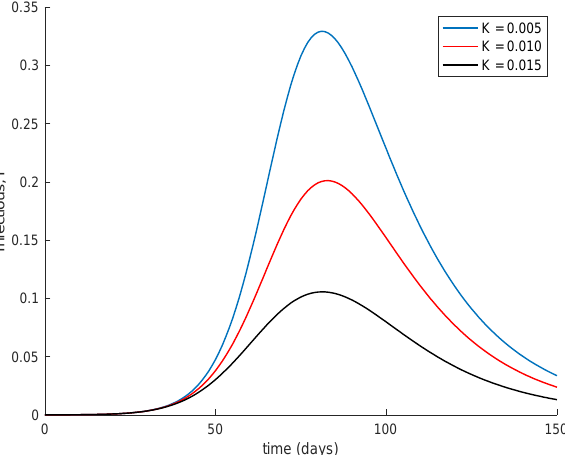
Figure 5. Dynamics of the infectious for different values of the vaccination gain.